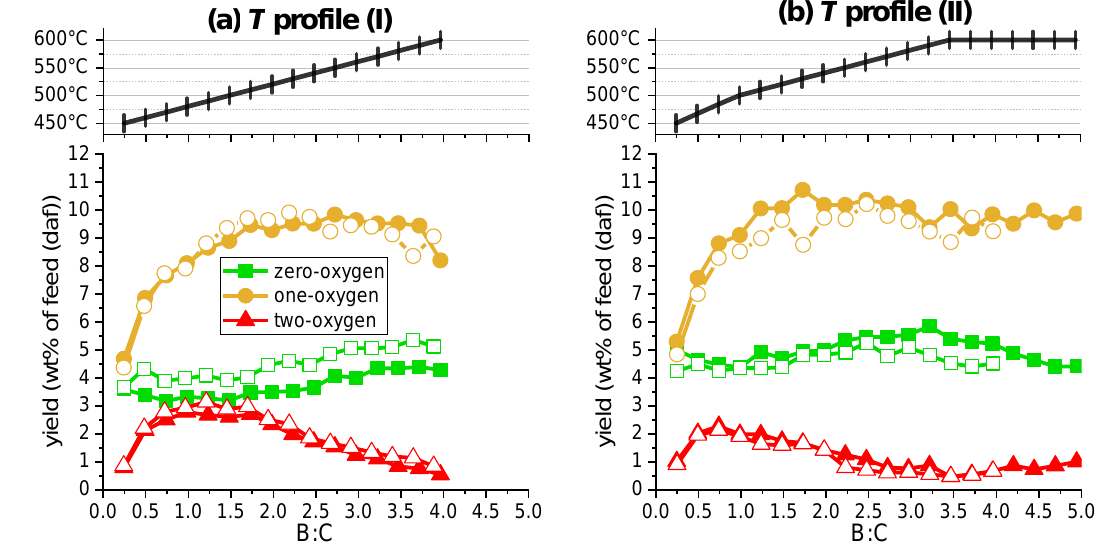
Figure 9. Yields (wt% of fed biomass (daf)) of hydrocarbons containing zero, one, and two or more oxygen atoms for upgrading over P/HZSM-5/γ-Al 2 O 3 at ( a ) temperature profile I and ( b ) at temperature profile II. The momentary yields obtained at each biomass injection as a function of increasing cumulative B:C ratio are shown. Open symbols show yields obtained from replicate runs with a new catalyst.